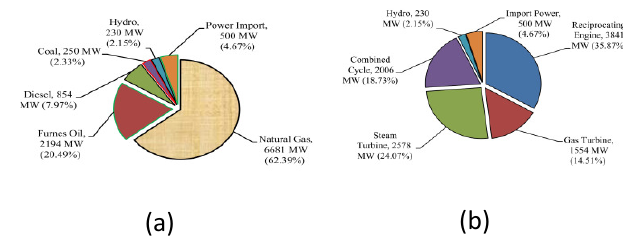
2: Installed electricity capacity (a) fuel type and (b) plant type [19] Figure